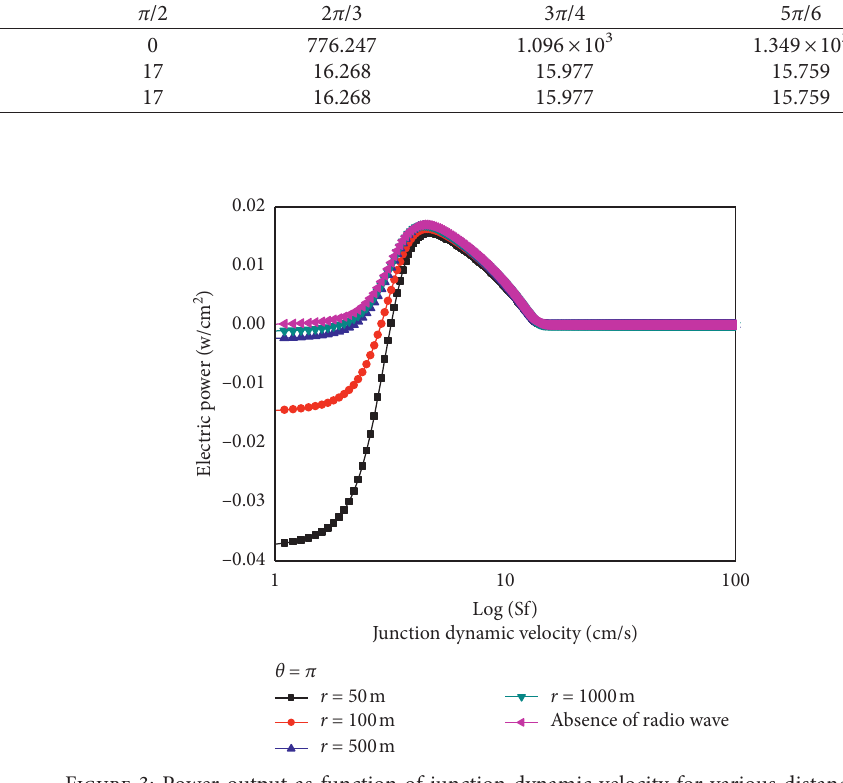
Table 2: Junction dynamic velocity at the equilibrium and efficiency for various incidence angles.